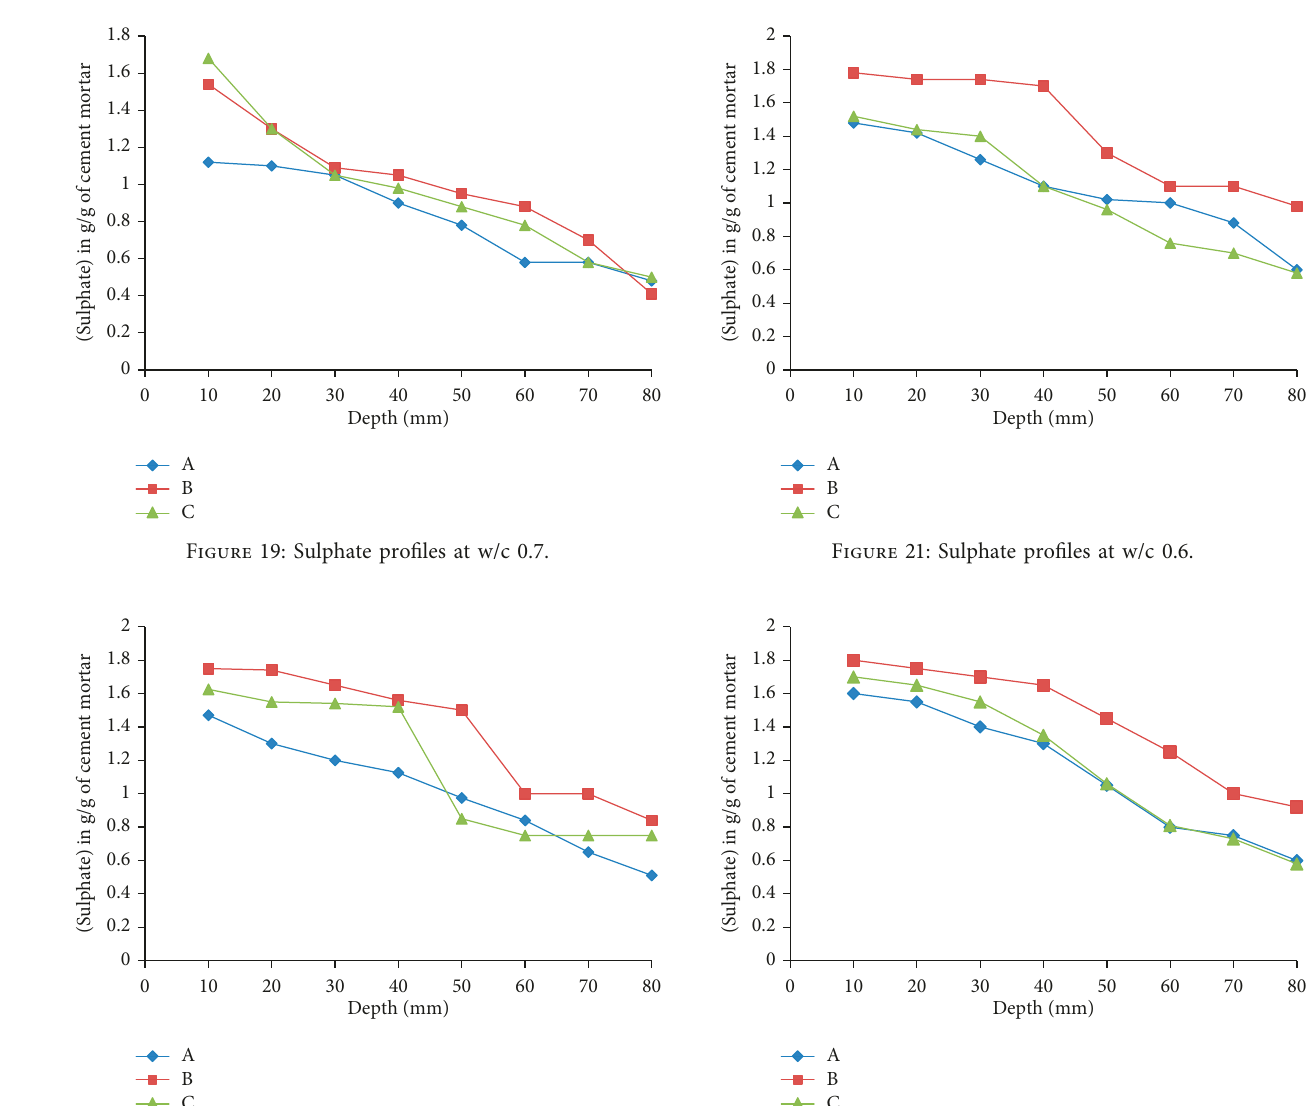
Figure 20: Sulphate profiles at w/c 0.5.